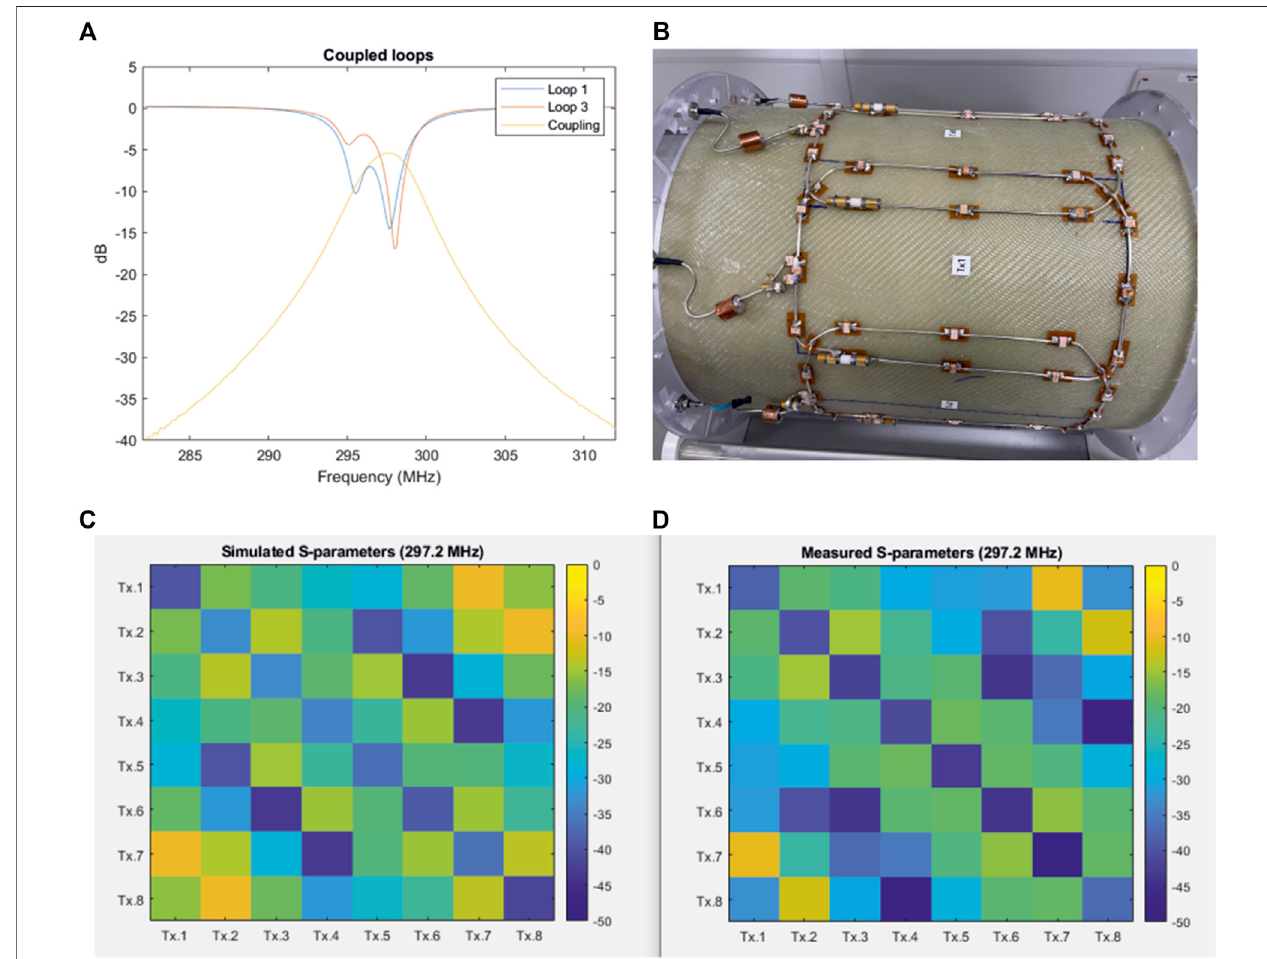
FIGURE 5 | (A) S-parameter plots of transmission and re fl ection demonstrating high coupling and split-resonance between second-neighbouring transmit elements in a coil without decoupling inductors. (B) Picture of the 8-channel loop array (140 m × 210 mm loops) with decoupled adjacent elements, but no decoupling between second neighbouring elements. (C,D) Simulated (C) and measured (D) S-parameter matrix of the 8-channel transmit array, respectively.